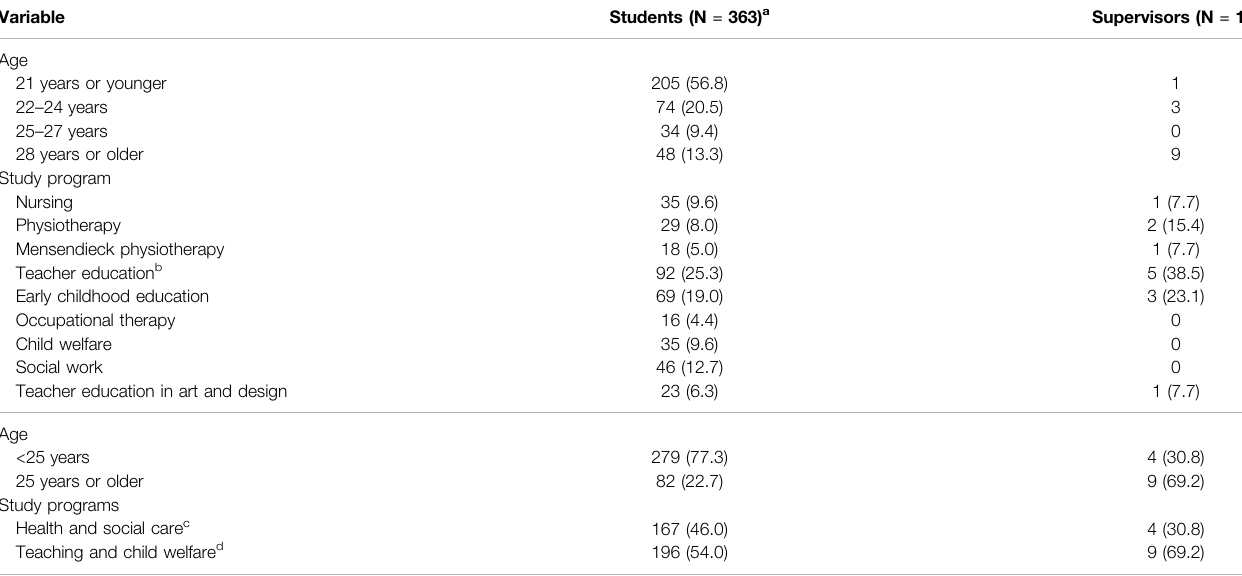
TABLE 1 | Distribution of respondents, N (%).